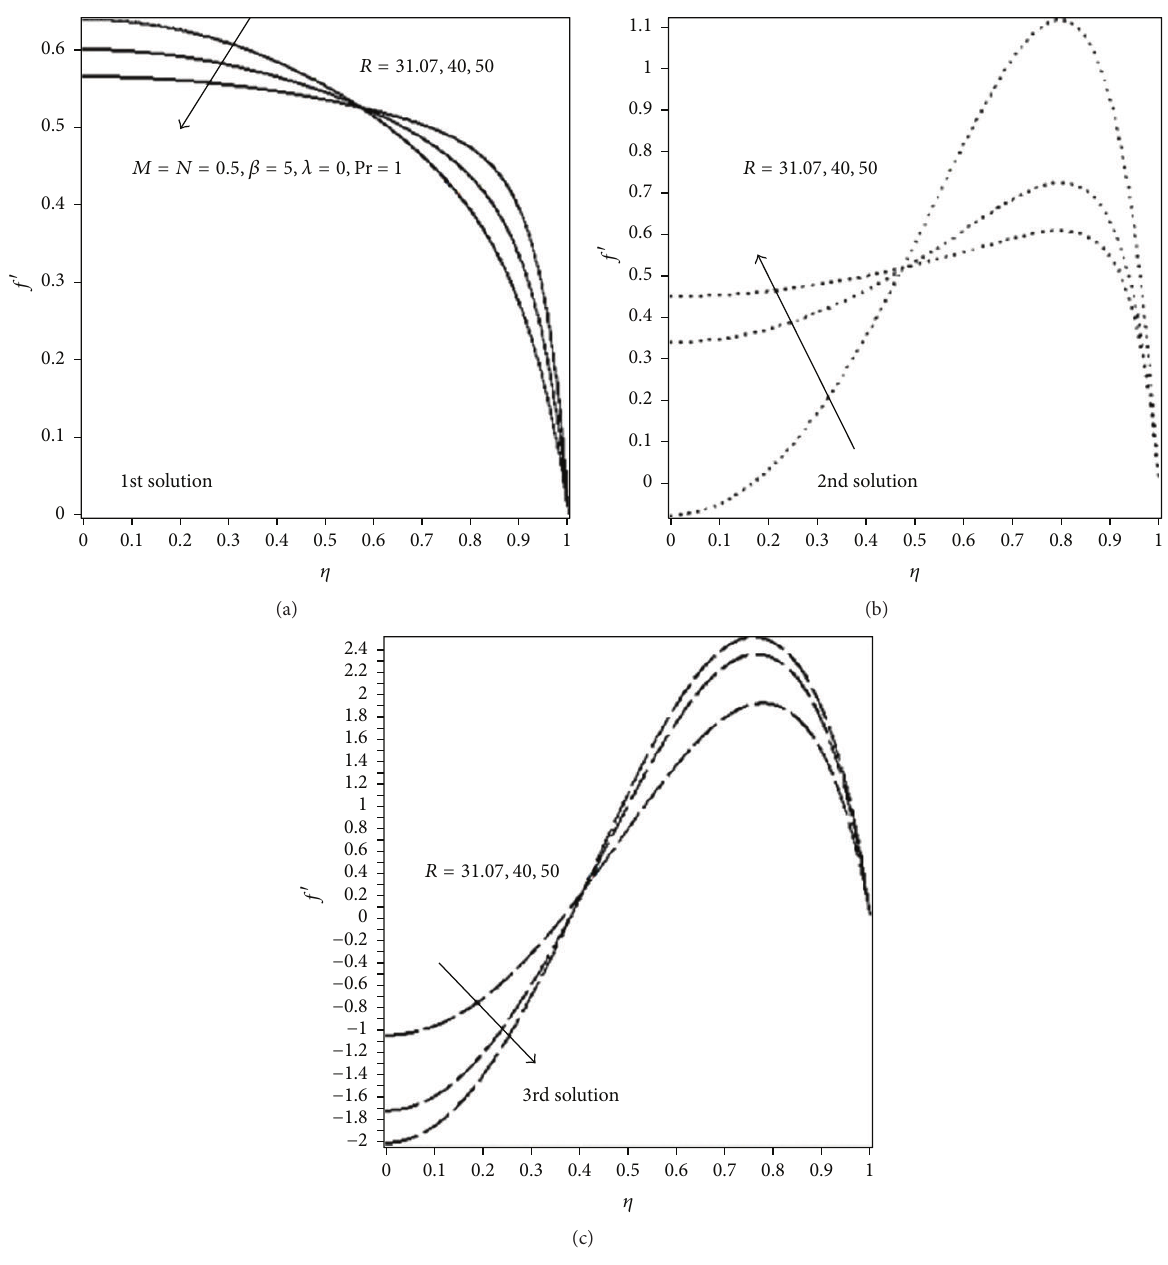
Figure 2: Effect of Reynold number 𝑅 on velocity profile 𝑓 󸀠 (𝜂)